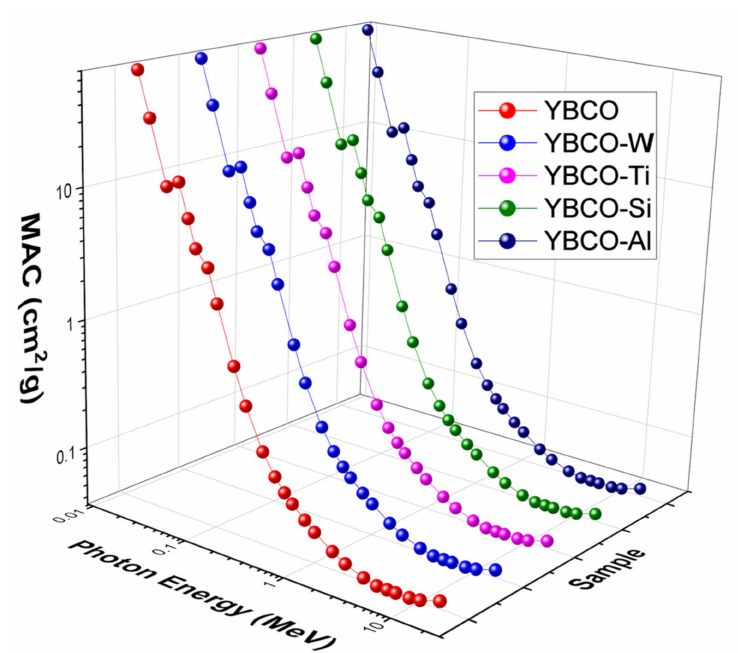
Figure 6. MAC values for the produced